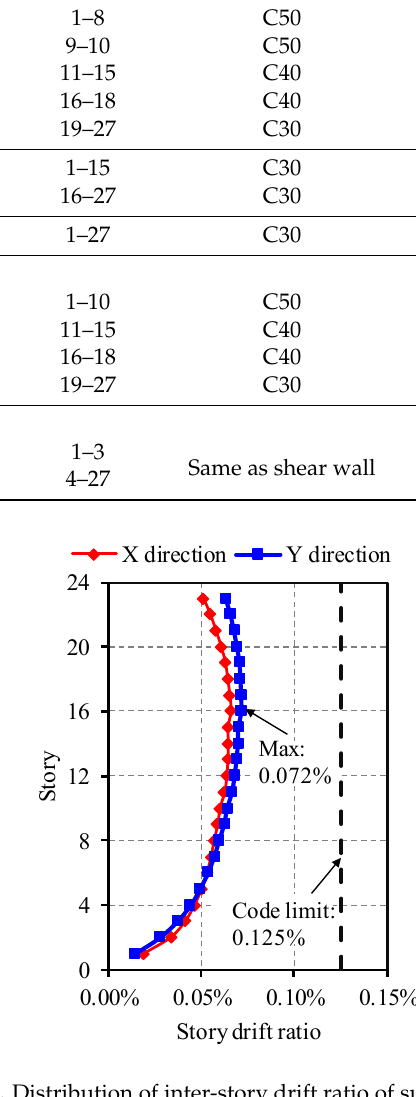
Figure 13. Distribution of inter ‐ story drift ratio of superstructure.